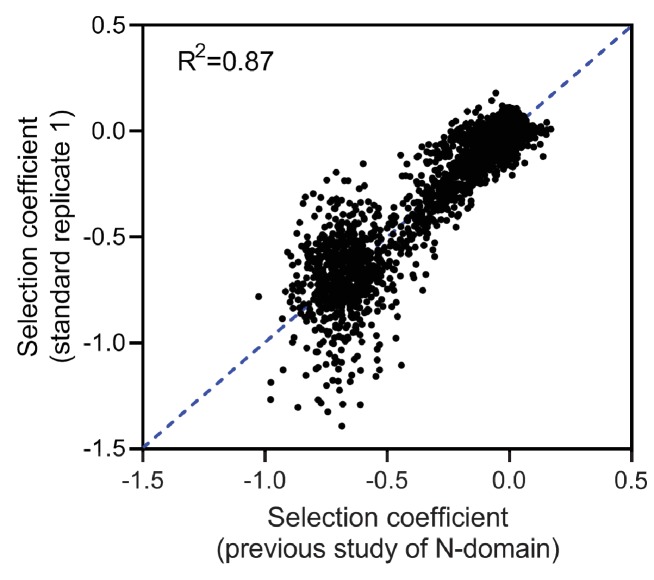
Measurement of selection coefficients for positions 2–220 in this study correlated strongly (R2 = 0.87) with estimates of the Hsp90 N-domain in a previous study (Mishra et al., 2016), indicating that biological replicates show high reproducibility.The blue dashed line indicates the line of best fit.